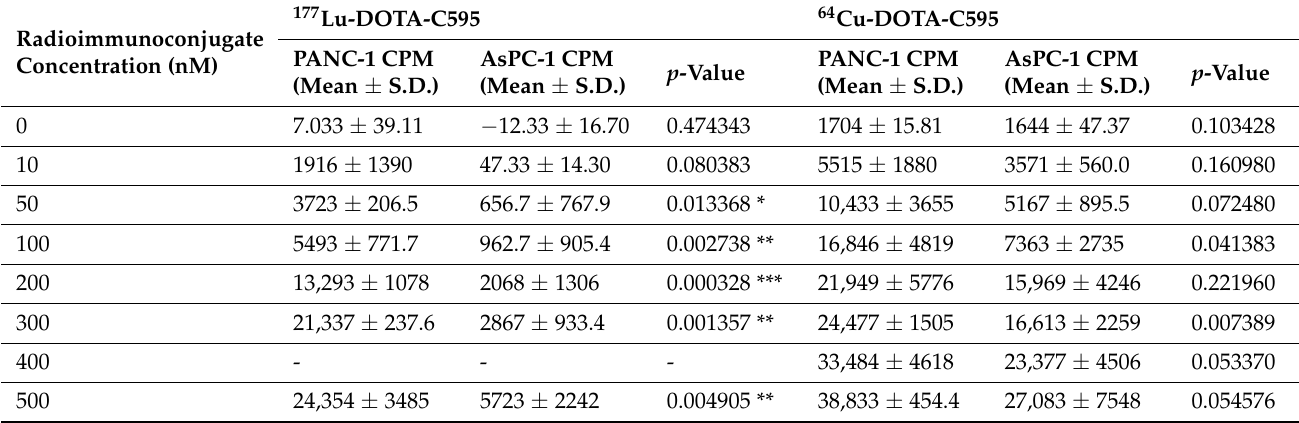
Table 4. Cell binding results.